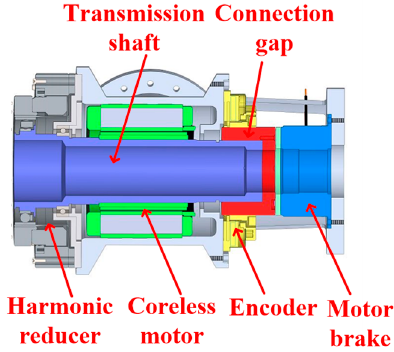
Figure 5. Schematic diagram of the joint module.